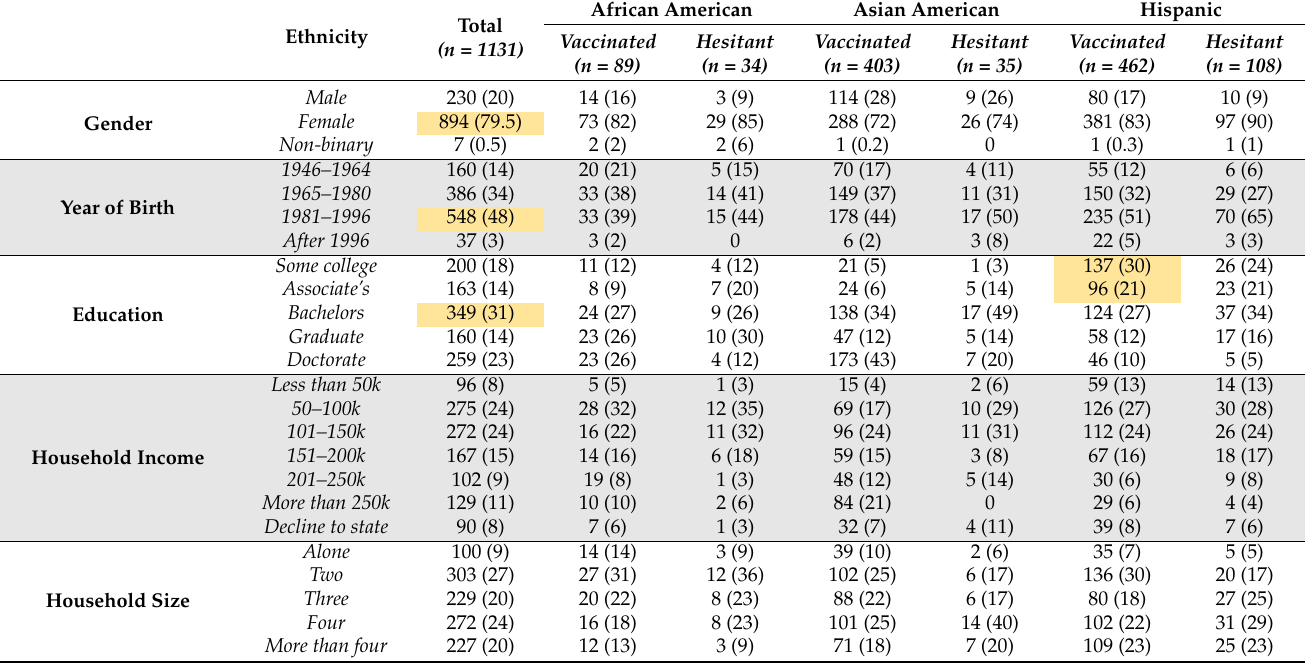
Table 1. Demographic Characteristics of the 1131 Health Care Workers of Color that responded to the survey, separated into three major ethnic groups. Results are reported as Count (Percent) in each column. Notable differences shaded in